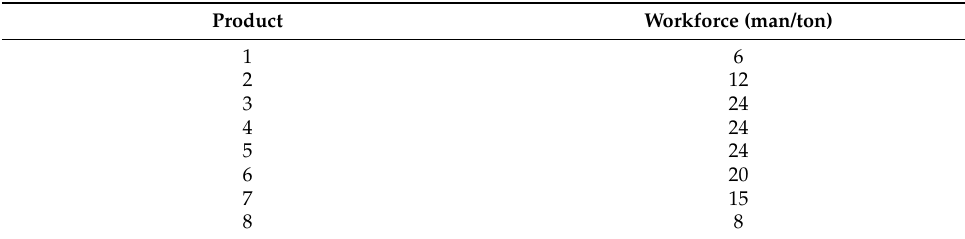
Table 7. Workforce Needed to Produce Each Product.